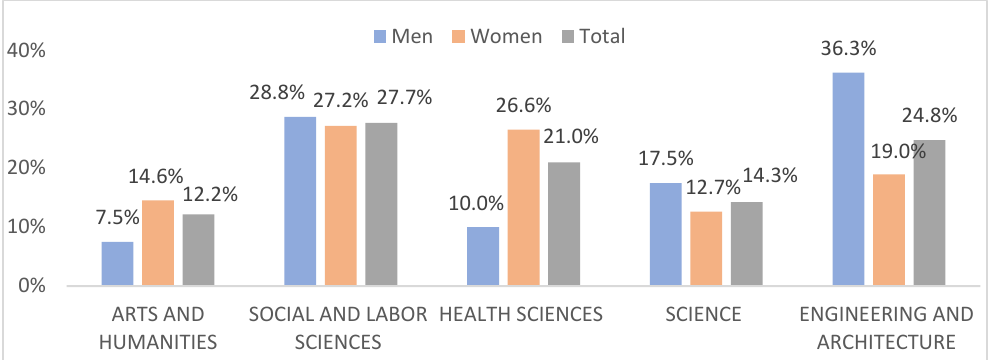
Figure 12. Percentages of answers obtained according to branch of study and gender.